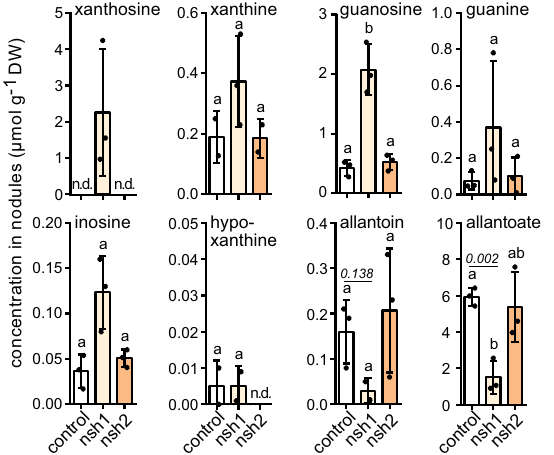
Fig. 4 | Metabolic alterations in nodule mutants of NSH1 and NSH2 . Quanti fi - cation of metabolites of purine catabolism and ureide biosynthesis in nsh1 , nsh2 and control nodule extracts. Error bars are SD, measure of the center is the mean value, n =3forcontrol, nsh1 and nsh2 .Arepeat( n )isapoolofnodulesfromasingle transgenicroot.Althoughdifferentmutantroots/nodulescancomefromthesame plant, in this experiment all null-mutant nodules came from roots of independent plants grown together. Statistical analysis with two-sided Tukey ’ s pairwise com- parison using the sandwich variance estimator. Different letters indicate p values <0.05.Selected p valuesareindicated,all p valuescanbefoundintheSourceData fi le. DW dry weight.